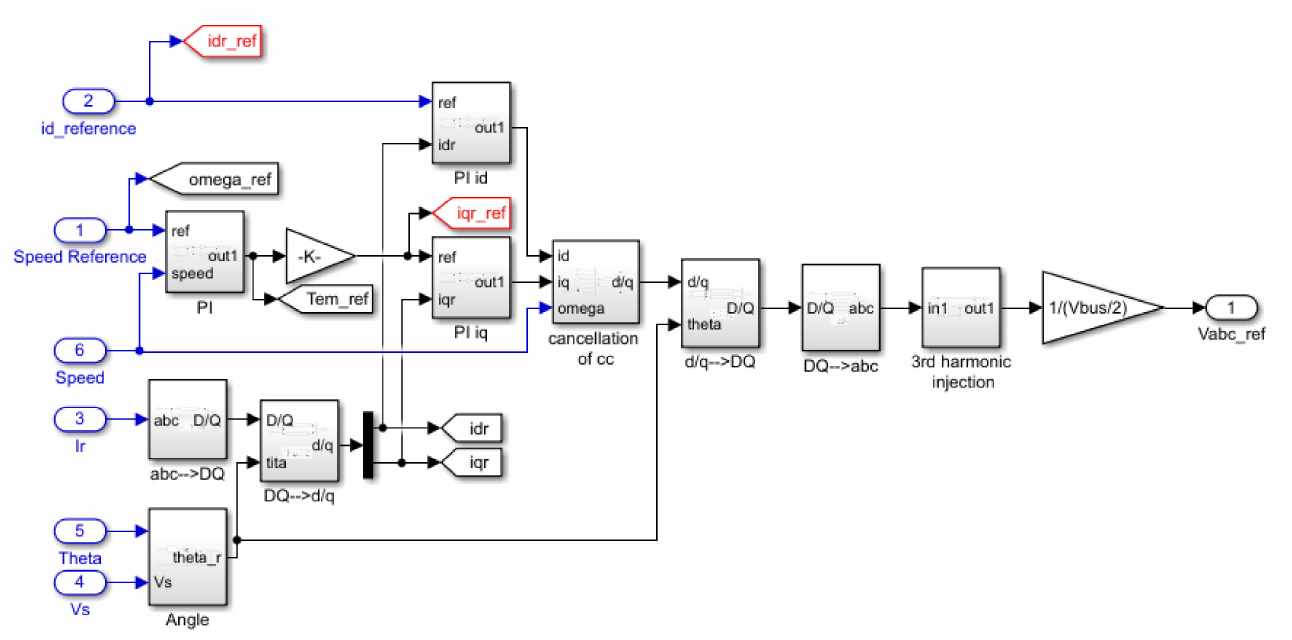
Figure 3. Stator flux-oriented Vector Control of RSC of